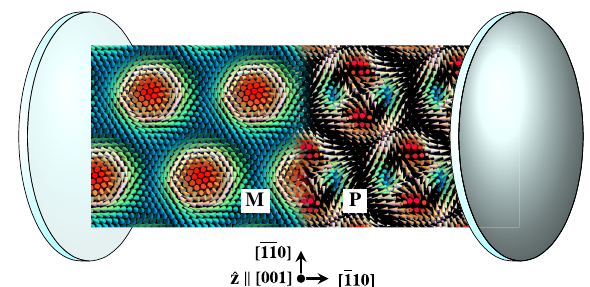
FIG. 1. Setup for studying magnetoelectrical magnon-photon hybridization in magnets with topologically nontrivial textures. A multiferroic skyrmion crystal phase of Cu 2 OSeO 3 is placed in an electromagnetic cavity. Left: magnetization M exhibiting a Bloch skyrmion winding. Right: polarization P with a